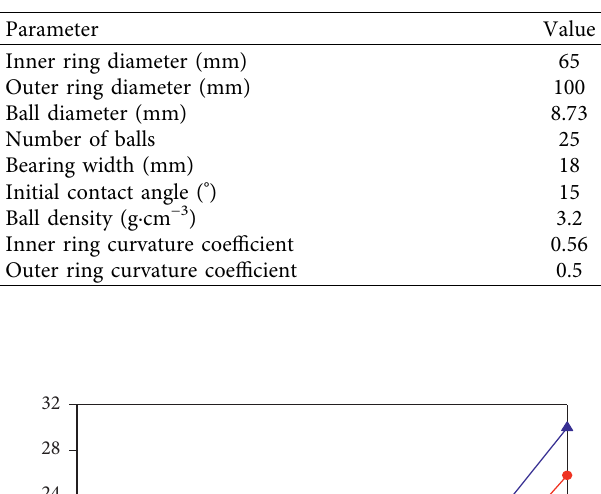
Table 3: Basic parameters of angular contact ball bearings H7013C.